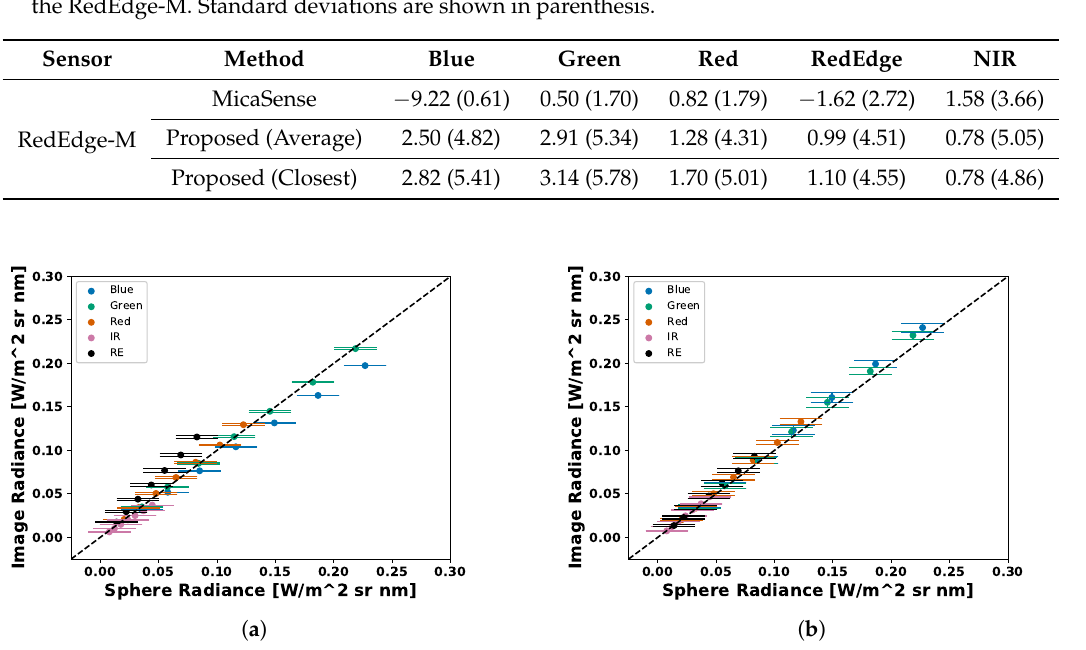
Figure 21. Scatter plot of average RedEdge-3 image radiance vs sphere radiance. Images converted to radiance using ( a ) MicaSense methodology ( b ) Average Vignette Proposed methodology. Proposed methodology produces less error as less spread is seen in the scatter plot.